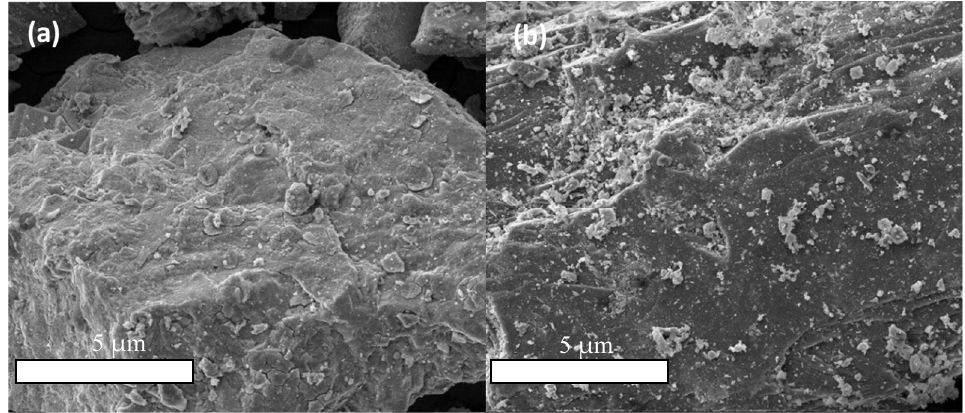
Figure 18. SEM comparison diagram without adding an ultrasonic field ( a ) and adding a sound field ( b ).